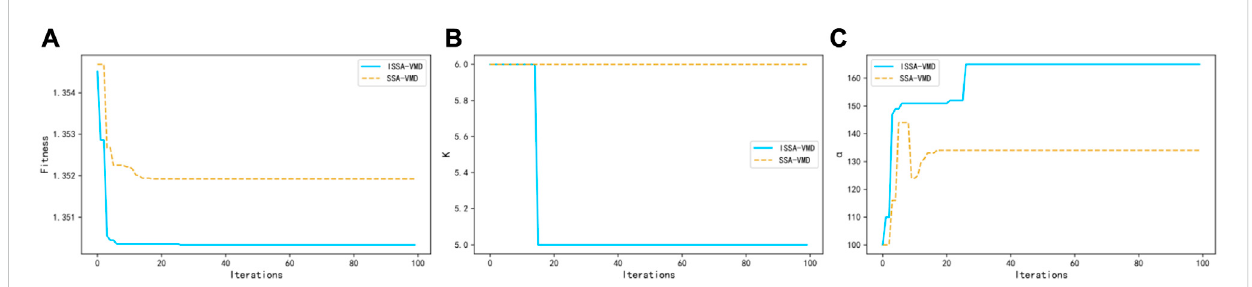
FIGURE 10 Comparison of VMD parameter optimization effects: (A) is the result of fi tness optimization, (B) is the optimization result of decomposition number K , and (C) is the optimization result of penalty factor α .